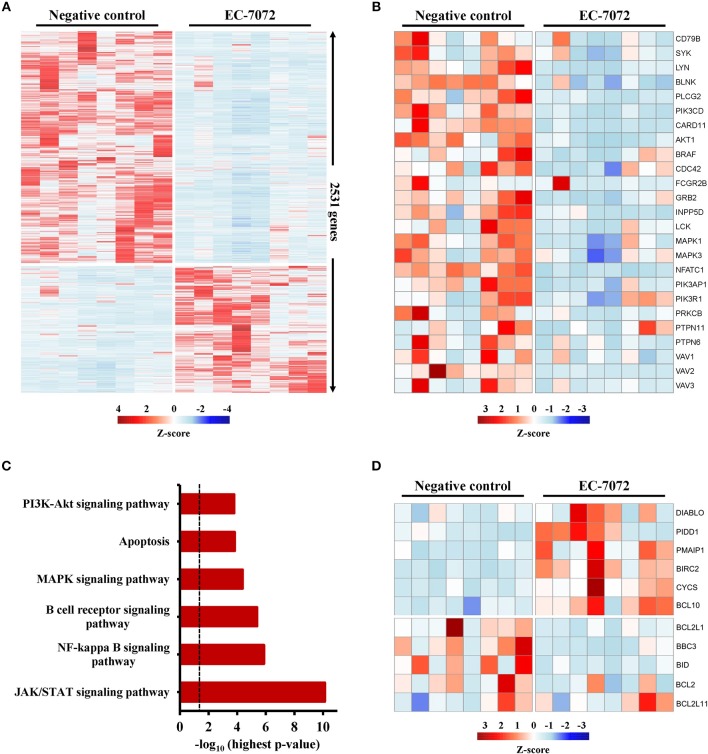
EC-7072 modulates the transcriptome of primary CLL cells. Isolated leukemia cells from patients with CLL (n = 8) were treated with 200 nM EC-7072 for 6 h. Total RNA was extracted and RNA-seq analysis was performed. (A) Heat map representation of statistically significant differences in gene expression between negative control (DMSO) and EC-7072-treated samples. The color scale represents the per-gene Z-score. Genes were selected based on adjusted p-value < 0.05, log2 (fold change) < −1 or > 1. (B) Heat map representation of expression of representative genes corresponding to BCR signaling that are significantly dysregulated by EC-7072 in CLL cells. The color scale represents the per-gene Z-score. (C) Selected relevant pathways for CLL cell homeostasis significantly modulated by EC-7072 obtained through KEGG pathway analysis. Bars represent the –log10 of the highest p-value obtained from the iterative pathway analysis (dashed line corresponds to p-value = 0.05). (D) Heat map representation of expression of genes related to apoptosis regulation that are significantly dysregulated by EC-7072 in CLL cells. The color scale represents the per-gene Z-score.